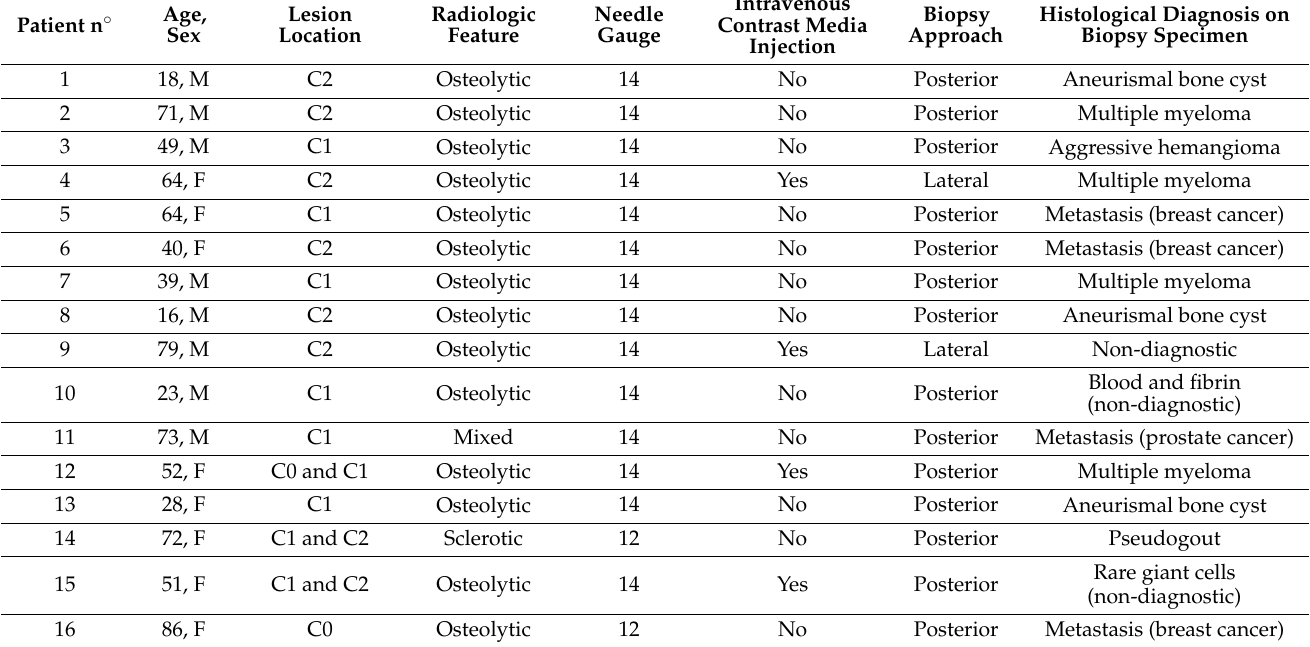
Table 1. Main characteristics of patients, lesions, technical data, and biopsy results. (C0 = occiput C1 = atlas C2 =